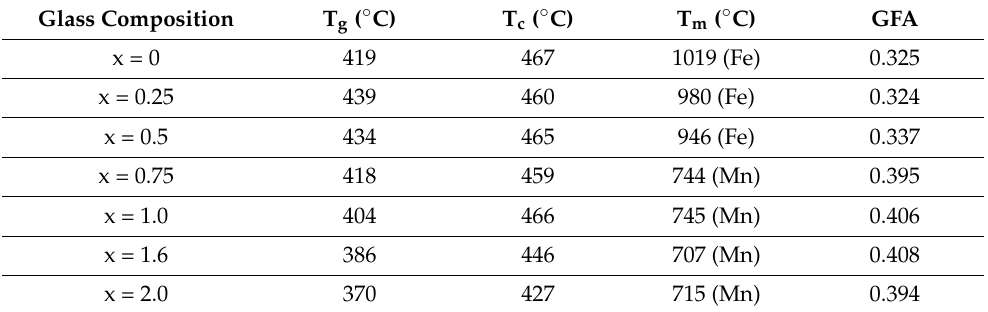
Table 1. Composition and thermal properties for the 3Li 2 O-xMn 2 O 3 -(2-x)Fe 2 O 3 -3P 2 O 5 (x = 0,